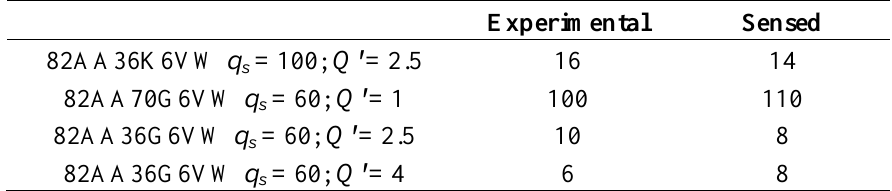
Table 2. Summary of grinding ratio ( G ) results of the test